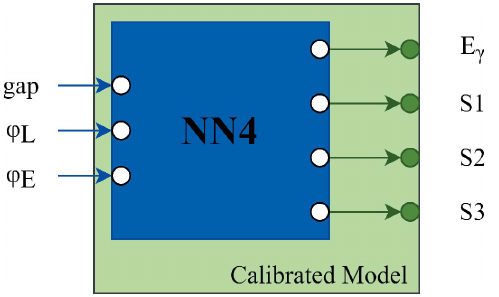
Figure 10 Architecture of the Calibrated NN model. The NN4 model acts as the base model with four outputs and the additional layer is added on top of NN4 (shown in green).